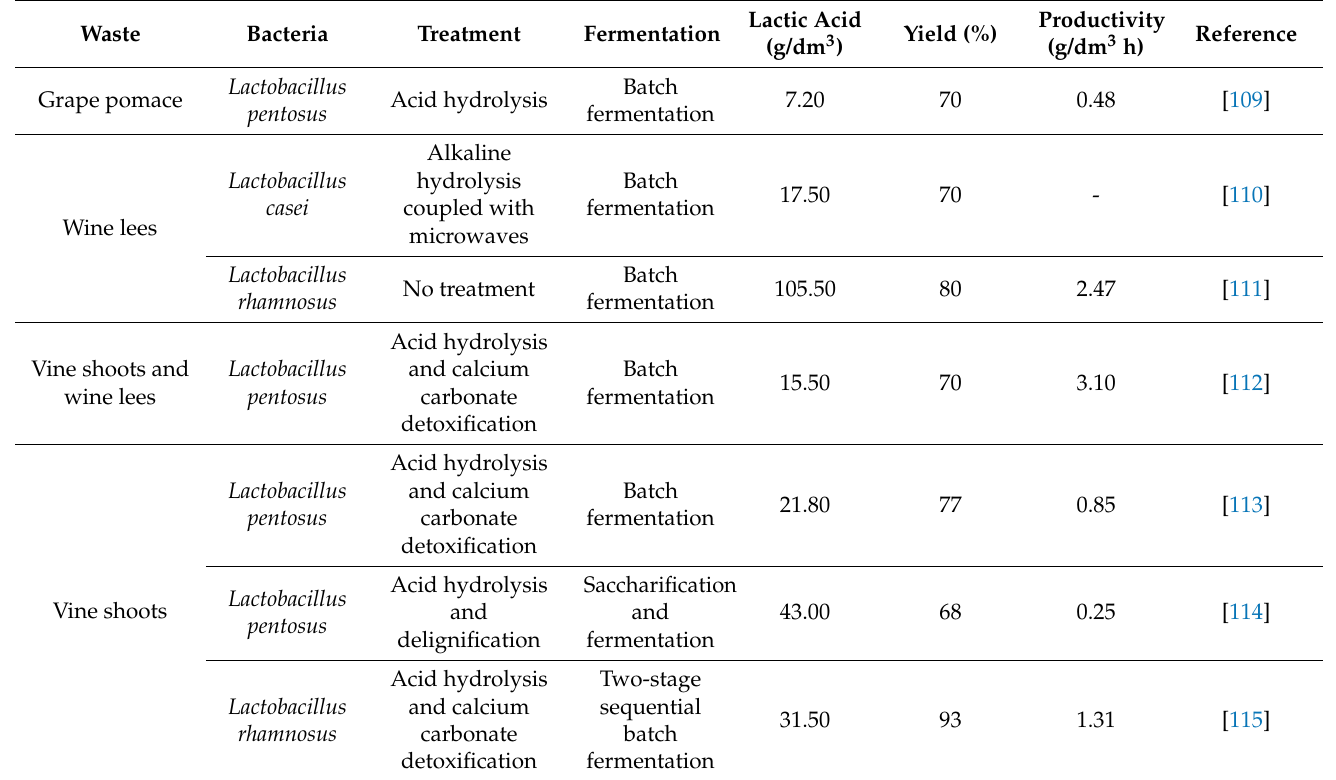
Table 6. Microbial synthetic route of lactic acid using various wine wastes as fermentative